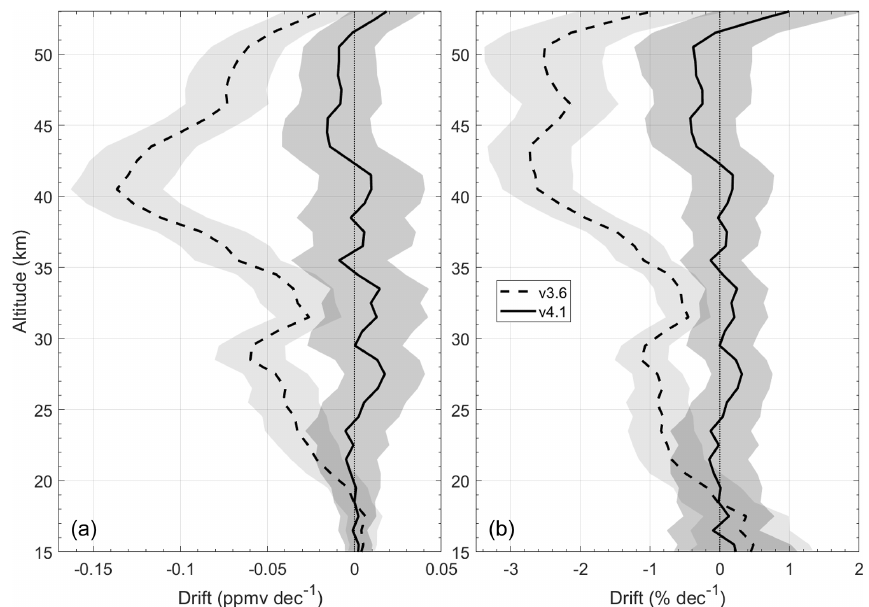
Figure 7. Weighted average ACE-FTS drift profiles for v3.6 (dashed lines) and v4.1 (solid lines) in (a) absolute differences and (b) relative differences. Shaded regions (semitransparent) represent the 99% confidence bounds.